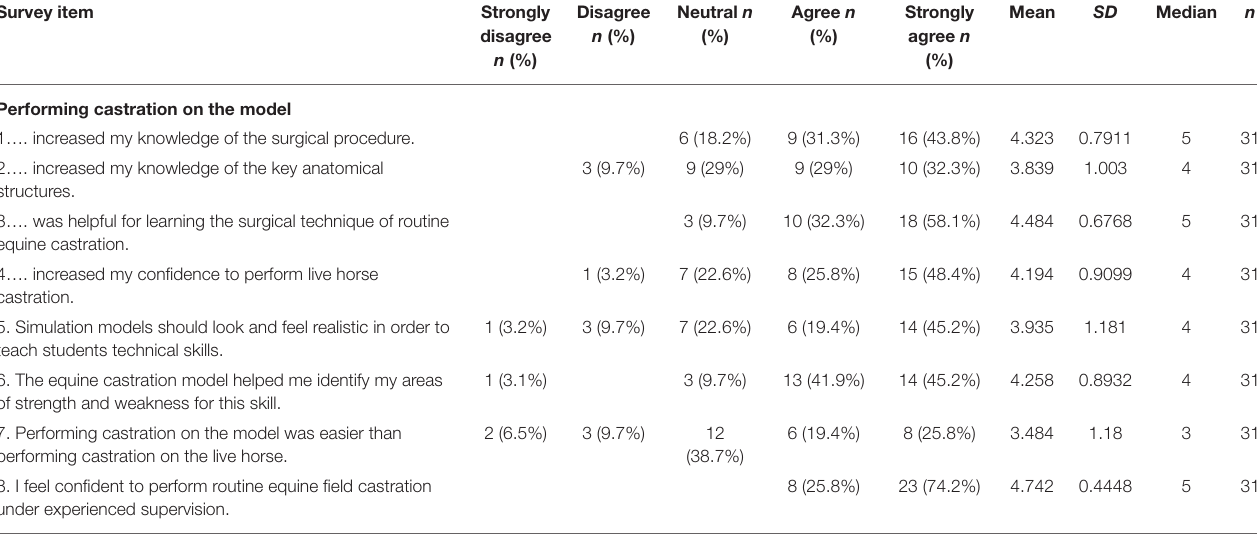
TABLE 3 | Students’ assessments of the model after to live horse castration. Survey